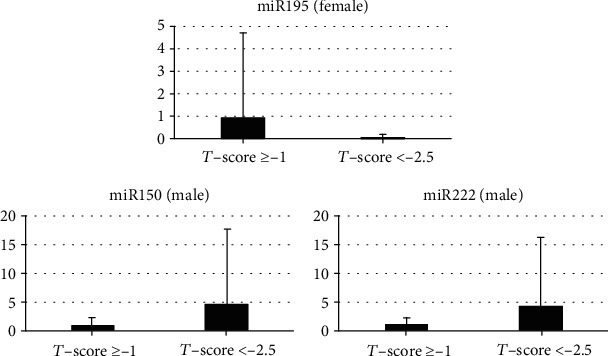
Quantitative real-time RT-PCR analysis of serum levels for five miRNAs (miR-195, miR-150, and miR-222). miR195 levels were significantly lower (0.03 ± 0.2 vs. 1.0 ± 3.7, p = 0.01) in female subjects with low T-scores, and miR150 (4.6 ± 13.1 vs. 0.03 ± 0.2, p = 0.05) and miR222 (4.3 ± 11.9 vs. 1.0 ± 1.2, p = 0.05) levels were significantly higher in males.